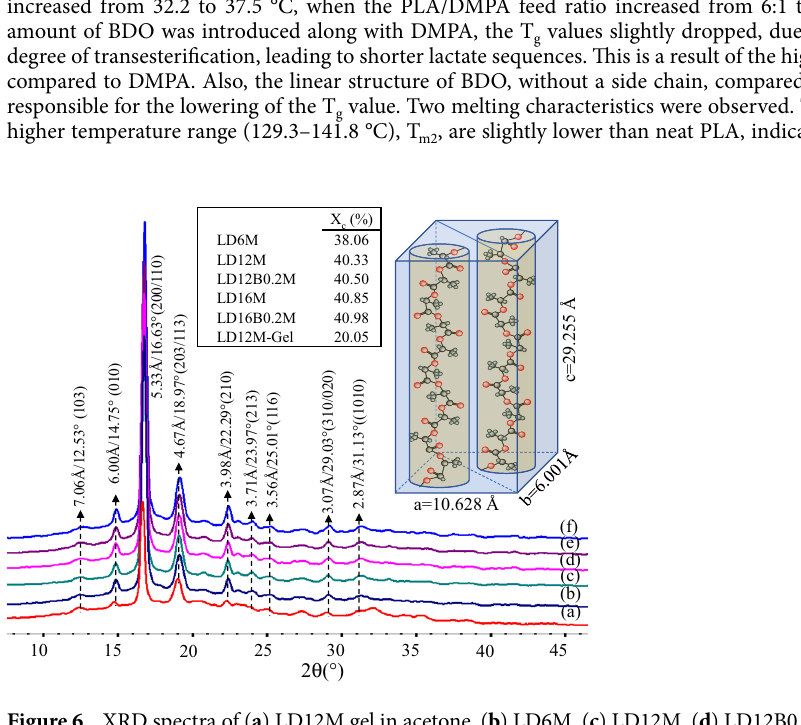
Figure 6. XRD spectra of ( a ) LD12M gel in acetone, ( b ) LD6M, ( c ) LD12M, ( d ) LD12B0.2 M, ( e ) LD16M, and ( f ) LD16B0.2 M, and proposed crystalline